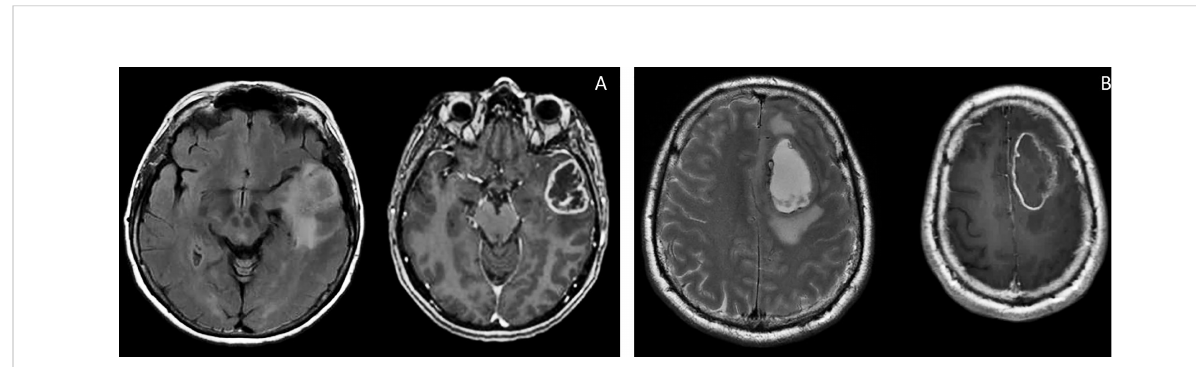
FIGURE 2 Brain MRI, T2 FLAIR, and T1 images of patients S (A) and G (B) . There are the same typical heterogenic changes of the signal with a ring-like contrast enhancement and a signal typical for edema around the tumors.